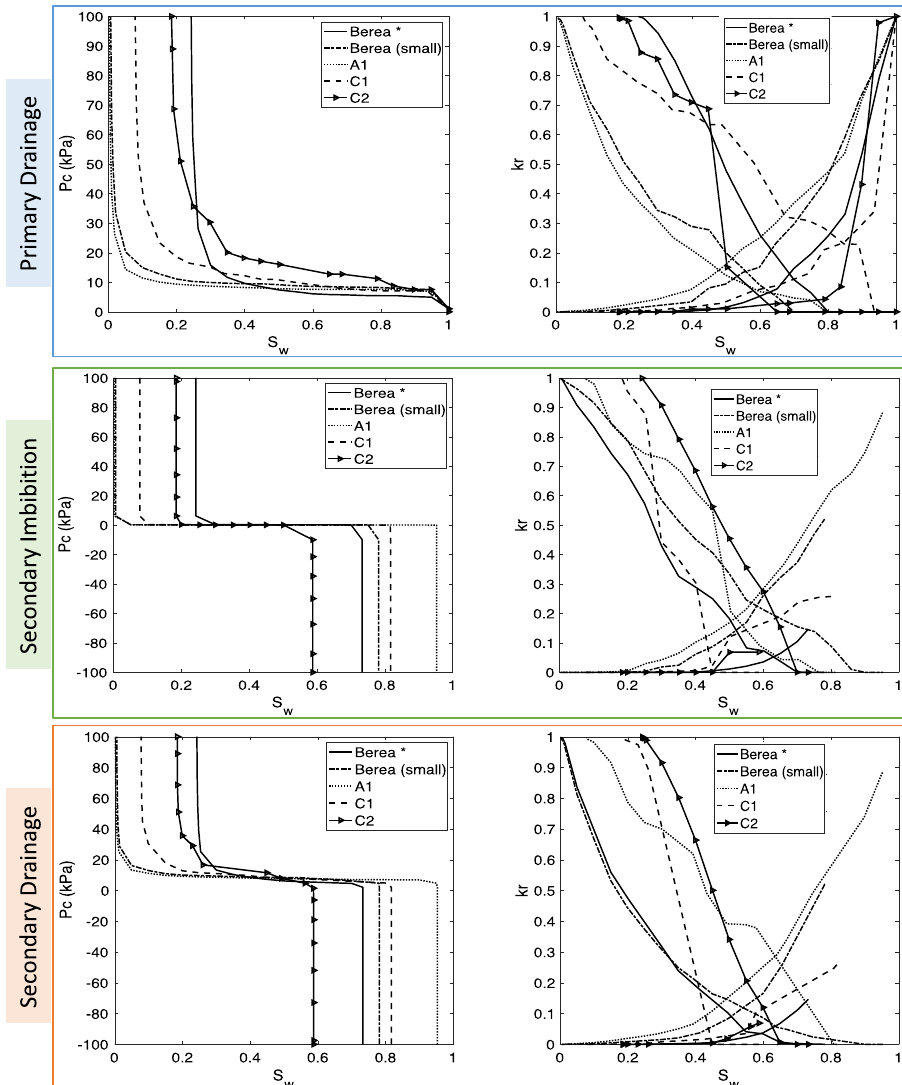
Figure 9. Sensitivity analysis of H 2 -brine system for different rock types. *Indicates the network that was used for the base-case of